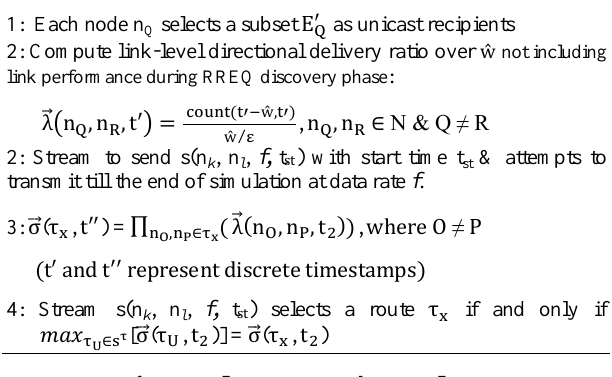
Algorithm 3 Directional Delivery Estimate and PDR